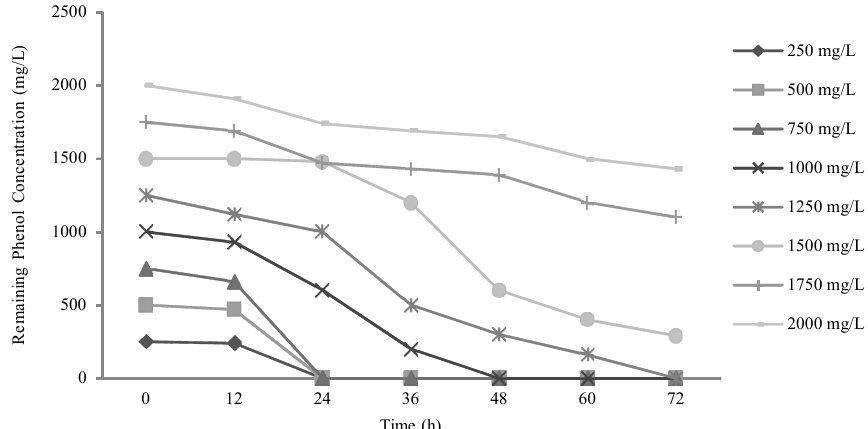
Fig. 6: Remaining phenol concentrations in the medium under different phenol